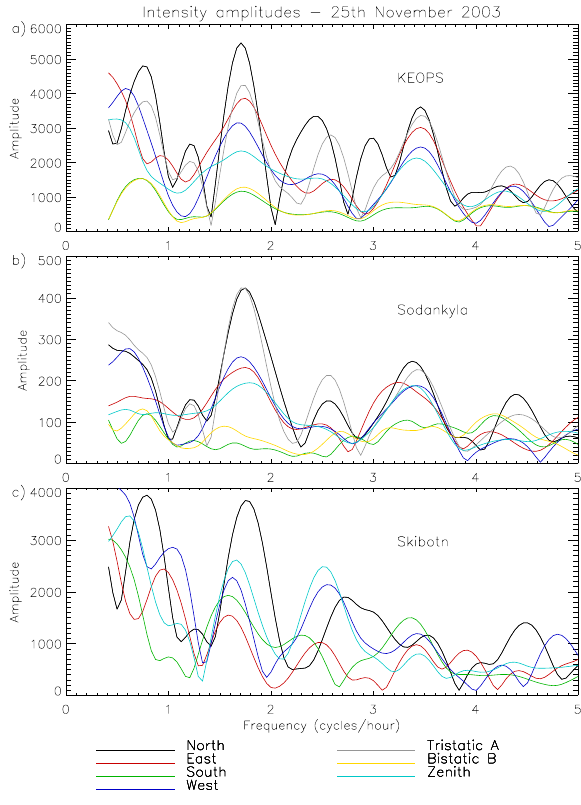
Fig. 6. Amplitudes of Lomb-Scargle periodograms for FPI inten- sities for (a) KEOPS, (b) Sodankyl¨a, and (c) Skibotn, on the 25 November